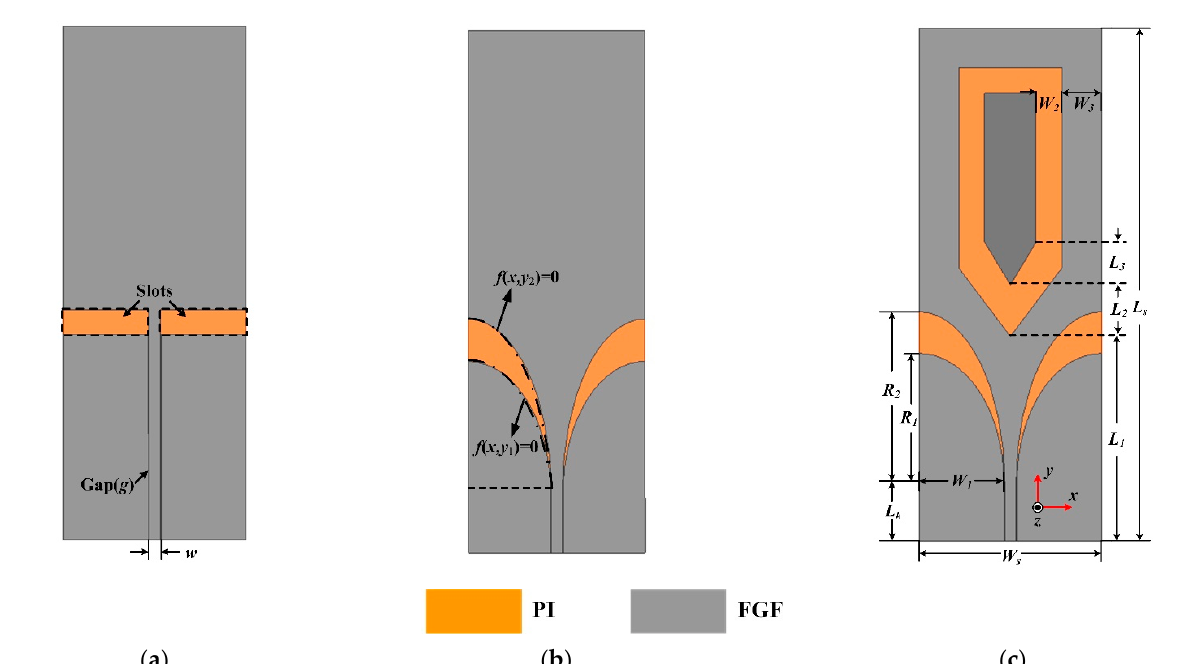
Figure 2. Proposed antenna design. ( a ) Ant-1: traditional monopole antenna. ( b ) Ant-2: modified monopole antenna. ( c ) Ant-3: ultrawideband wearable antenna.